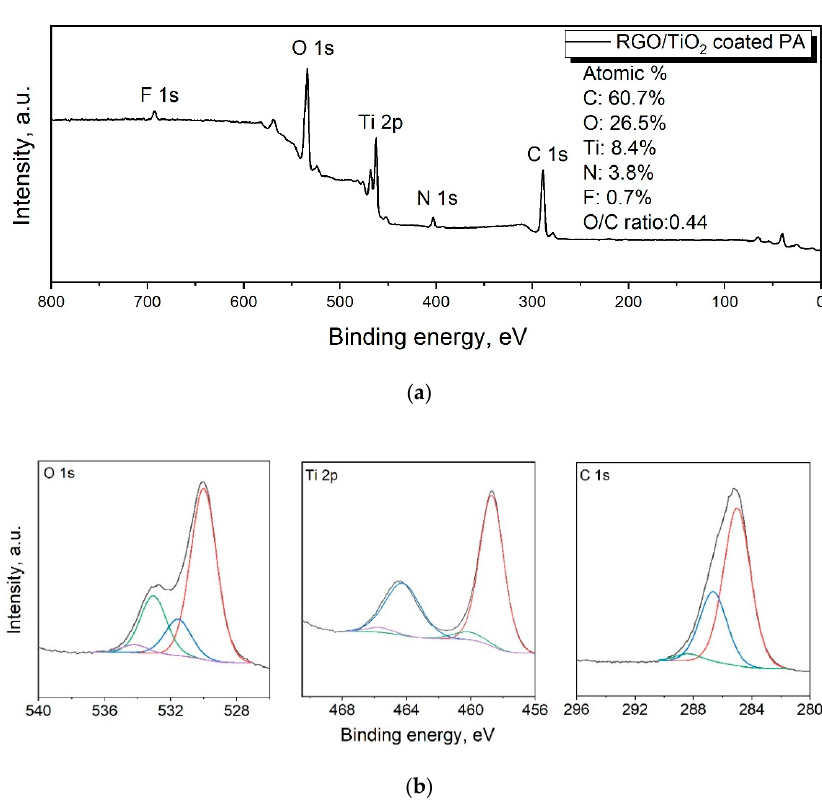
Figure 5. XPS ( a ) and C 1s, O 1s and Ti 2p XPS ( b ) spectra of RGO/TiO 2 coated CO.